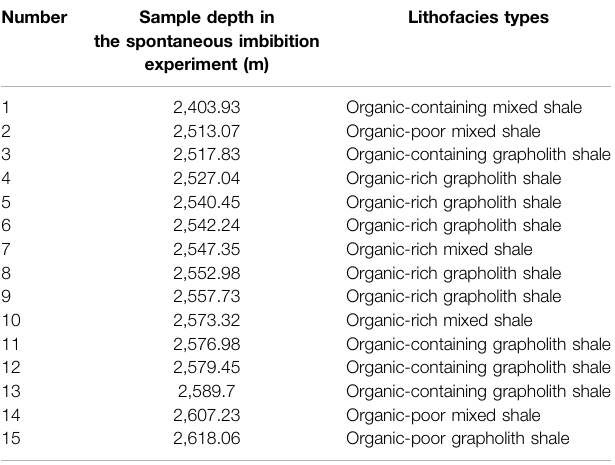
TABLE 3 | Lithofacies types of shale in the spontaneous imbibition experiment. Number Sample depth in the spontaneous imbibition